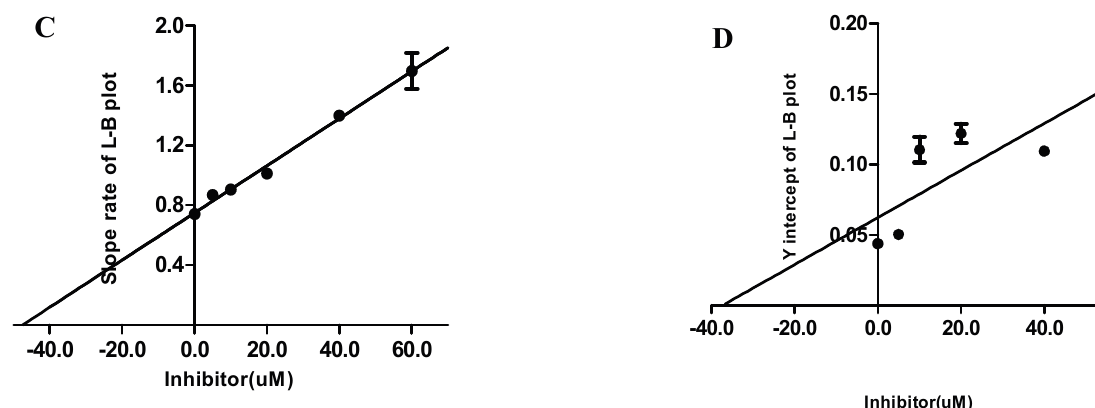
Figure 4. Lineweaver-Burk plots. Intracellular uptake velocity of R-123 (nM/min) was examined in cells incubated with R-123 ( A ). Cells were incubated in different concentrations of NCB (0, 5.0, 10, 20, 40, 60 μ M) at 37 °C, for 60 min. The